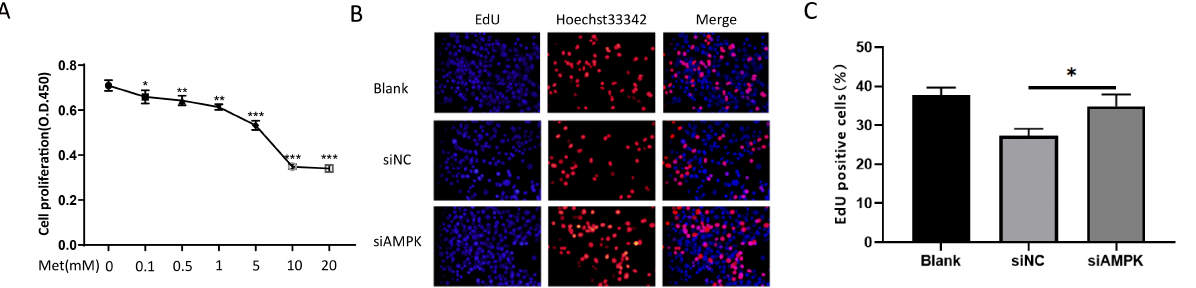
Figure 3. Metformin inhibits the proliferation of NIH 3T3 cells by activating AMPK. ( A ) The CCK8 test was applied to assess NIH 3T3 cells treated with metformin at various doses for 24 h. ( B , C ) Cell proliferation analysis by EdU incorporation assay. Transfected with siAMPK for 24 h, the cell proliferation ability of NIH 3T3 cells was measured by EdU assay. The percentages of EdU − positive cells are quantified in the bar graph. All data are expressed as the means ± SDs of values from triplicate experiments. * p < 0.05, ** p < 0.01, and *** p < 0.001. Blank: NIH 3T3 cells, siNC: siAMPK negative control group, siAMPK: NIH 3T3 cells transfected with si − Prkaa1 − mus −